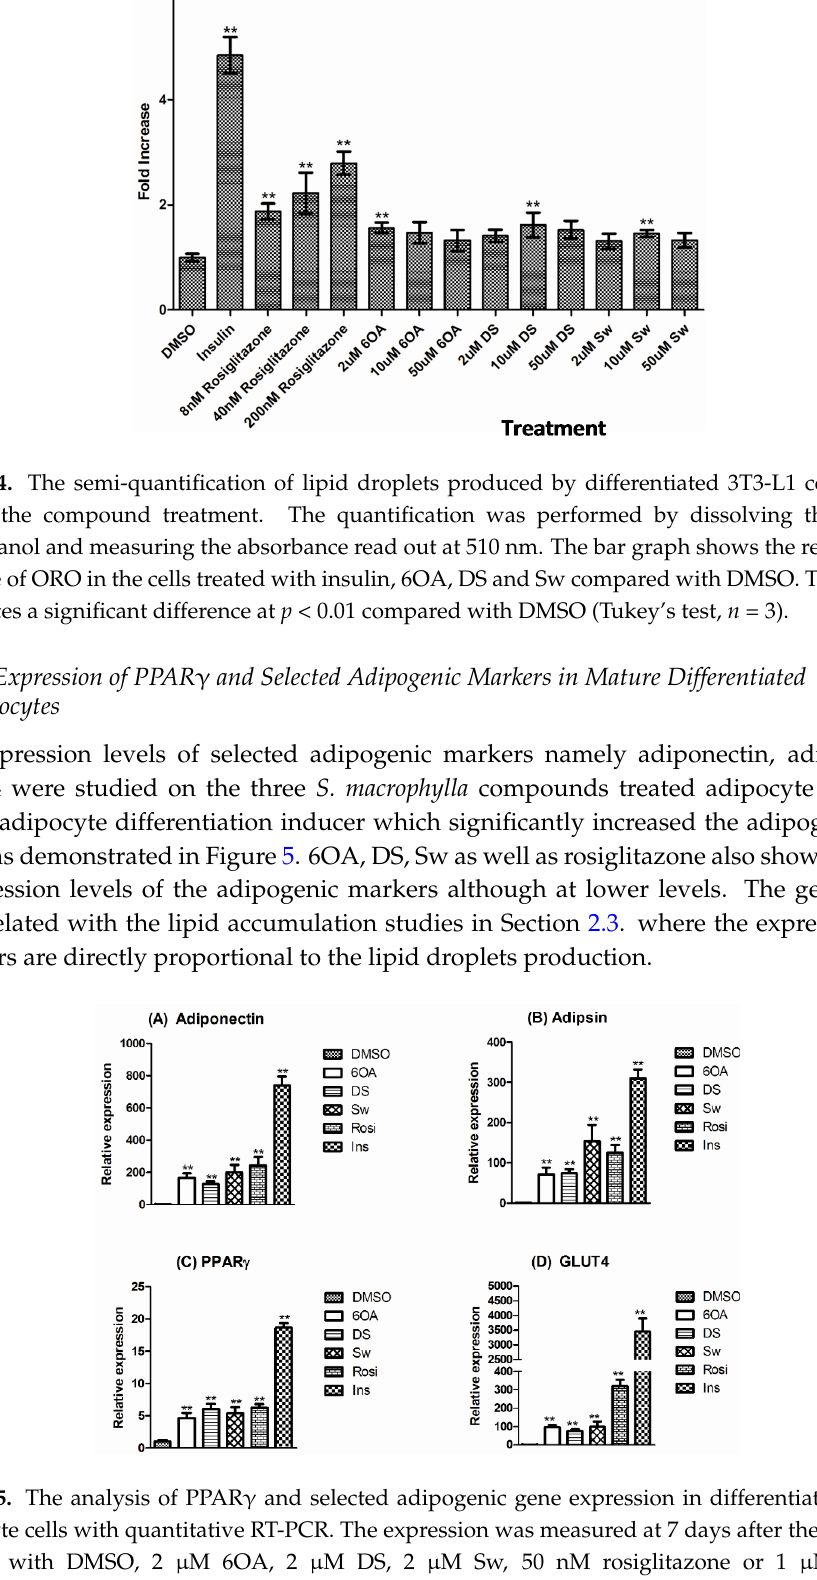
Figure 5. The analysis of PPAR γ and selected adipogenic gene expression in differentiated 3T3-L1 adipocyte cells with quantitative RT-PCR. The expression was measured at 7 days after the treatment of cells with DMSO, 2 µM 6OA, 2 µM DS, 2 µM Sw, 50 nM rosiglitazone or 1 μ M insulin. ( A ) Adiponectin; ( B ) Adipsin; ( C ) PPAR γ and ( D ) GLUT4. ** denotes a significant difference compared with the basal expression from DMSO treatment at one-fold (Tukey’s test, p < 0.01, n = 3). The expression values were normalized against a housekeeping gene, β -actin.